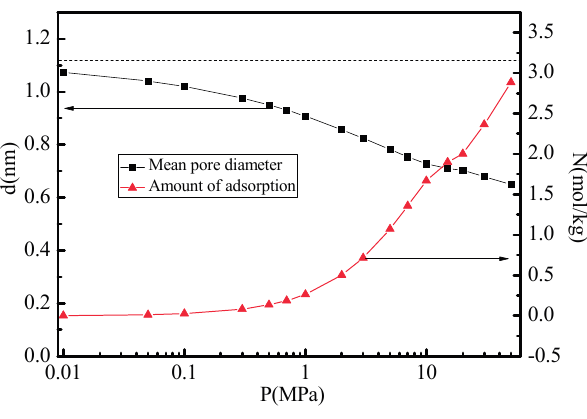
Figure 5. Varying mean pore diameter and amount of H 2 adsorption at different pressures and 298.15